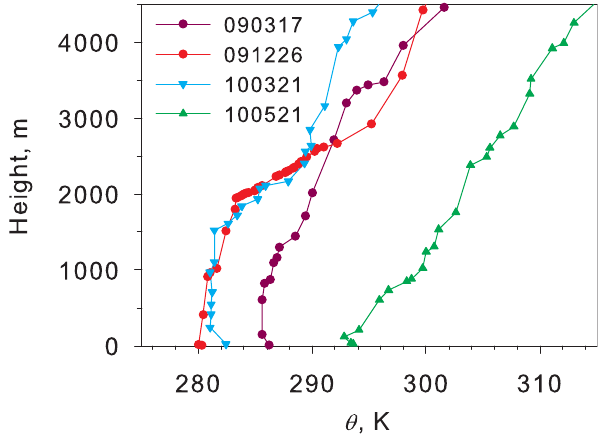
Fig. 11. Vertical profiles of potential temperature at Yonago for 2009 and Matsue for 2010. The upper air observation site was moved from Yonago to Matsue, which are located about 80 and 110km west of Tottori. Meteorological data are obtained from the JMA web site (http://www.data.jma.go.jp/obd/stats/etrn/upper/